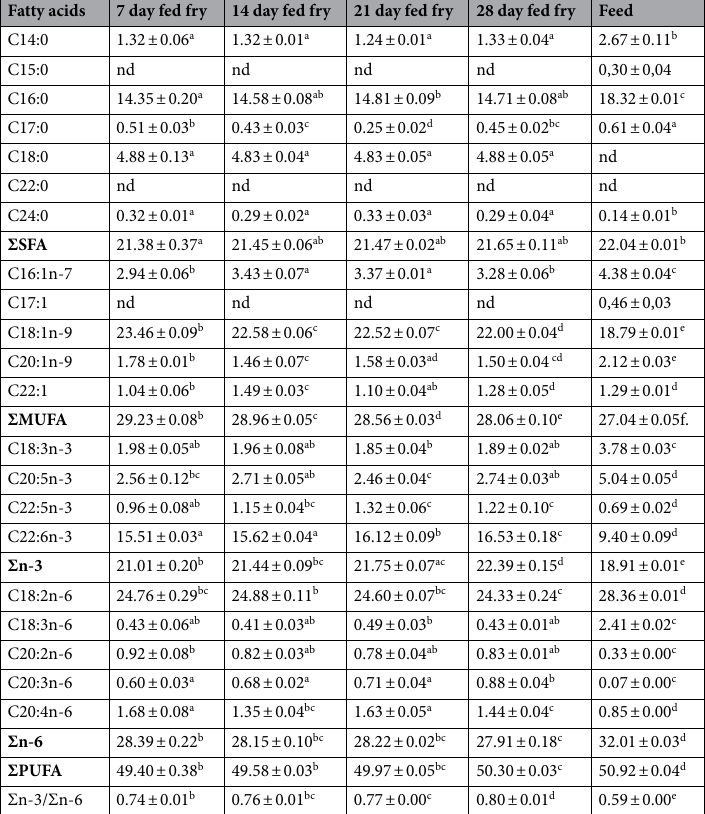
Table 6. Fatty acid composition of fed fry of Oncorhynchus mykiss and diet.* *The meaning of the symbols is given under Table 1. Σ: Total. ΣSFA: Total Saturated Fatty Acid. ΣMUFA: Total Monounsaturated Fatty